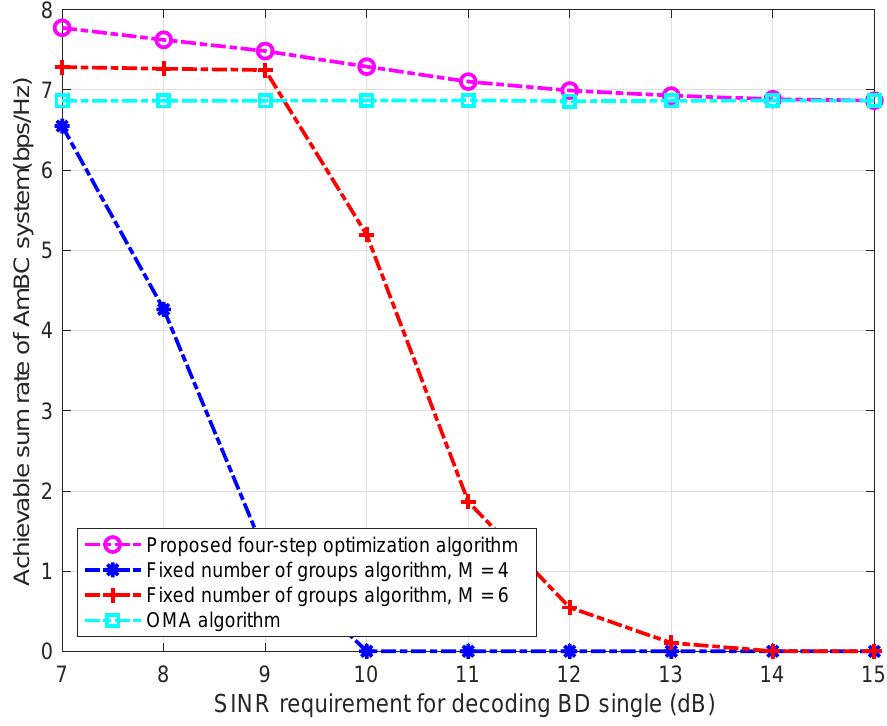
Figure 4. ASR vs. the SINR requirement decoding the BD signal.